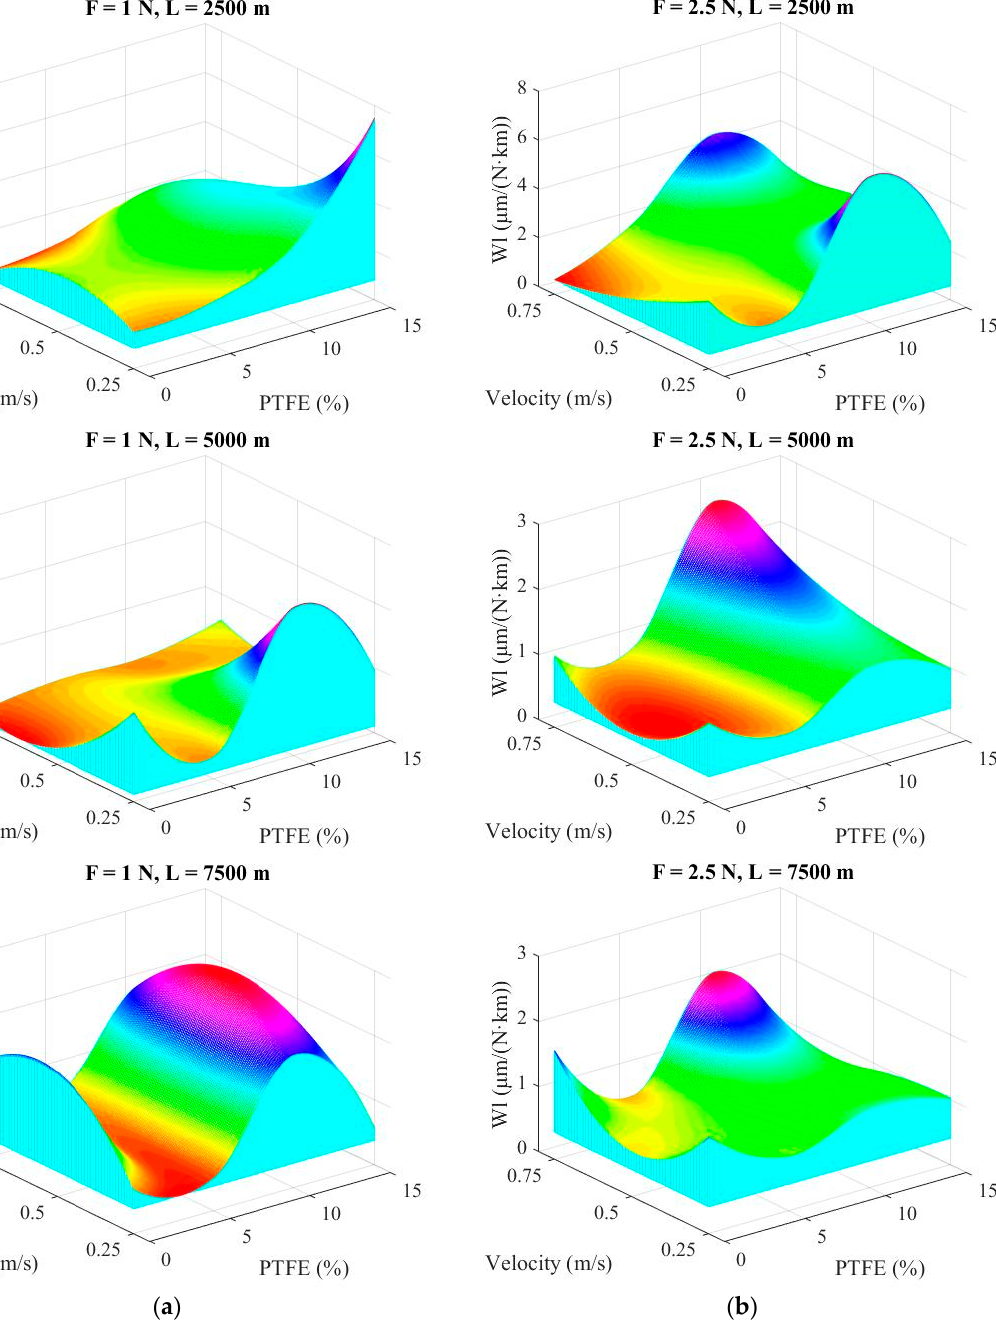
Figure 8. Maps of linear wear rate: ( a ) F = 1 N; ( b ) F = 2.5 N.